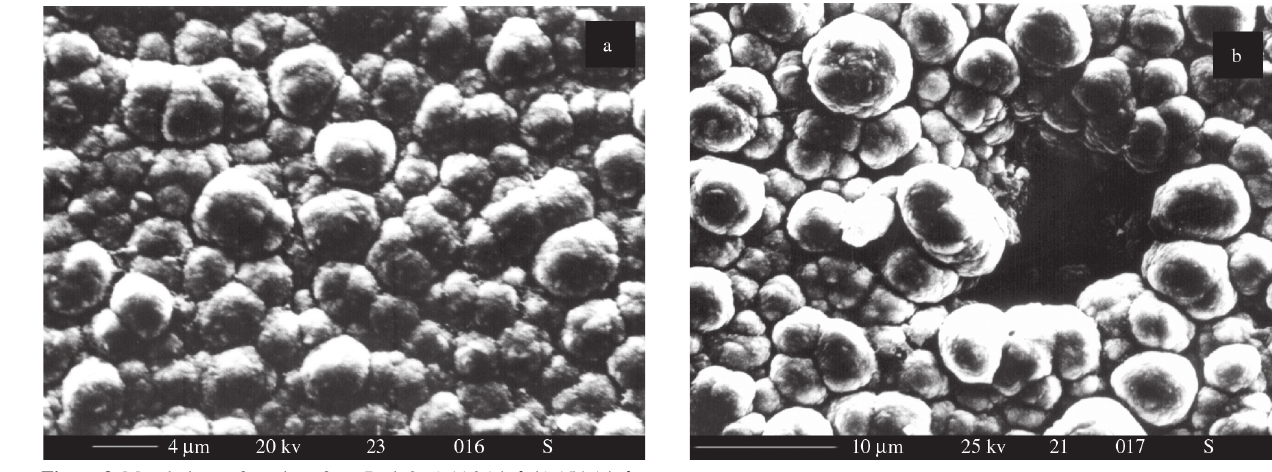
Figure 3. Morphology of coatings from Bath 3: a) 116 A/m 2 ; b) 154 A/m 2 .